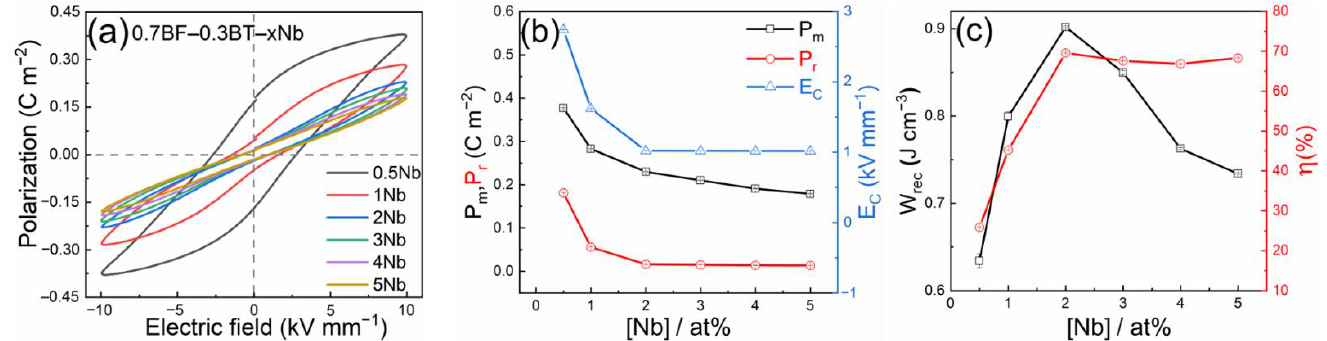
Figure 5. ( a ) Polarization – electric field (P – E) loops of 0.7BF – 0.3BT – xNb ceramics, ( b ) maximum and remanent polarization (P m and P r ) and coercive electric field (E C ) as a function of Nb concentration, ( c ) recoverable energy density (W rec ) and efficiency (η) as a function of Nb concentration, measured at room temperature.